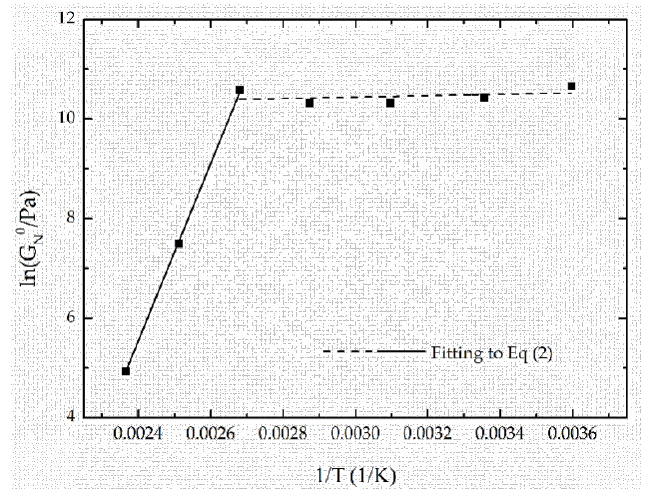
Figure 8. Evolution of G N0 with temperature for a selected oleogel (EAL1 at 5 wt %).